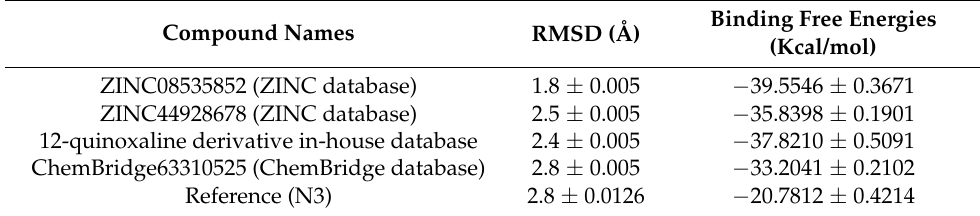
Binding Free Energies (Kcal/mol)